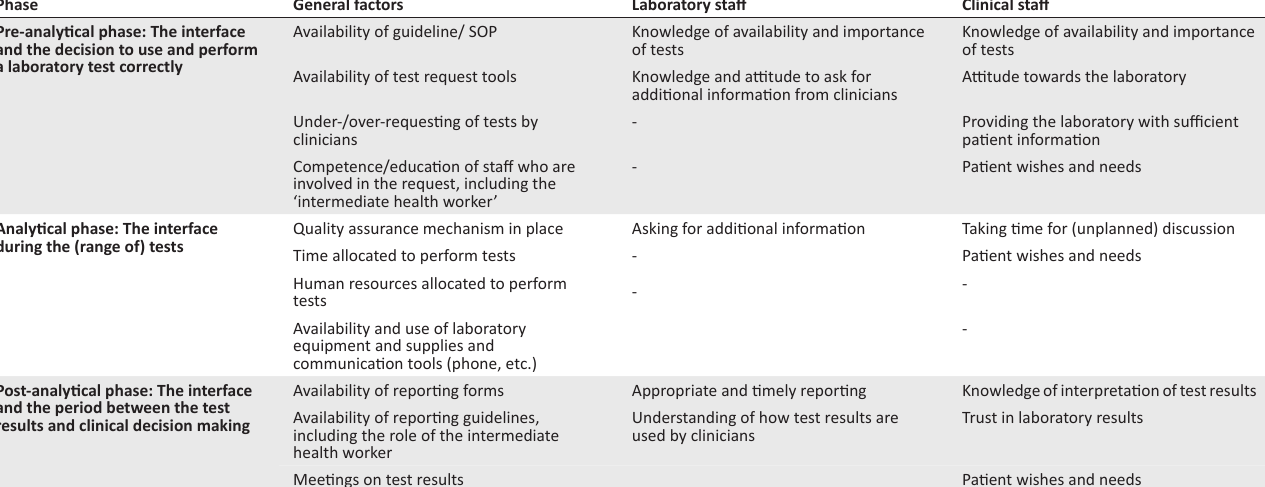
TABLE 1b: Analytical framework. This framework was developed to test our conceptual model, 16 and displays the three phases where clinicians and laboratory workers interact: pre-analytical, analytical and post-analytical. Each phase consists of organisational and personal factors (Table 1a).